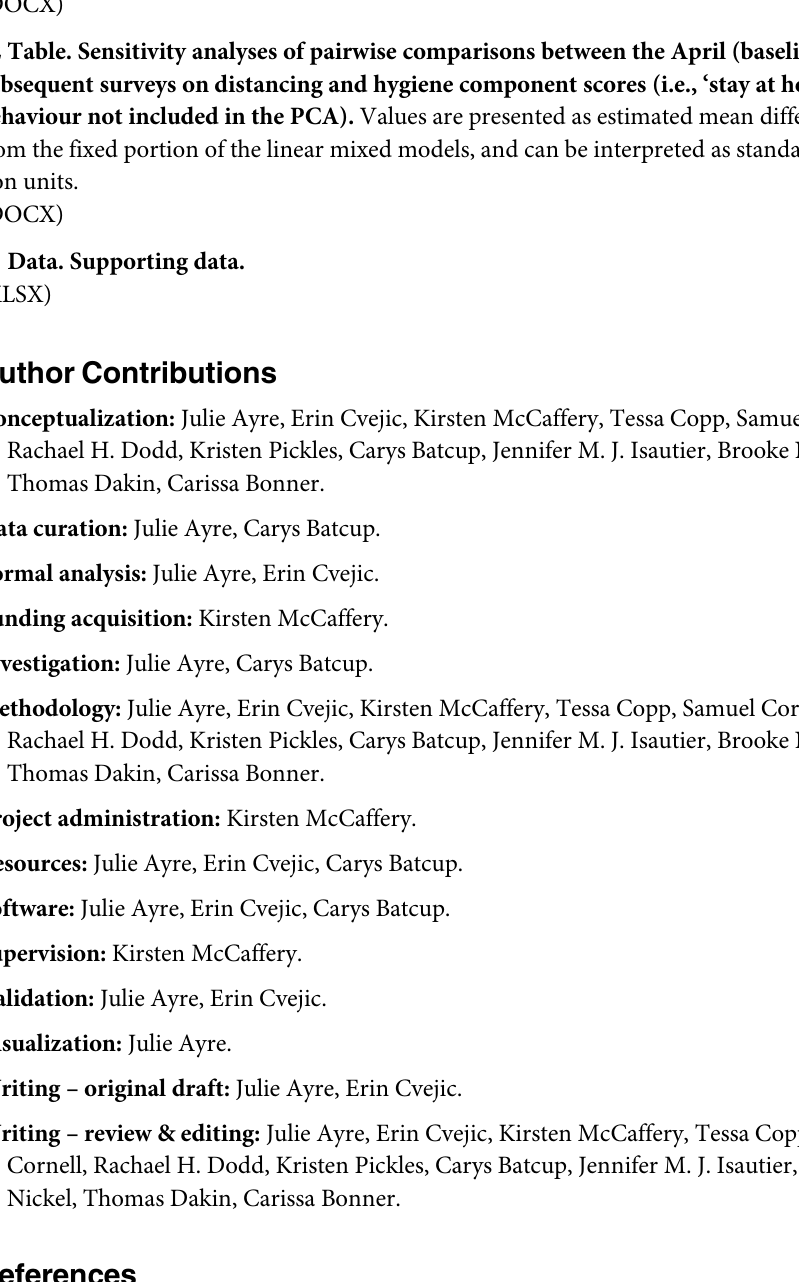
S1 Table. Descriptive characteristics of analysis sample (N = 1843) and full sample invited for follow-up (N = 3216) at baseline (April). S2 Table. Sensitivity analyses of pairwise comparisons between the April (baseline) and subsequent surveys on distancing and hygiene component scores (i.e., ‘stay at home’ behaviour not included in the PCA). Values are presented as estimated mean differences from the fixed portion of the linear mixed models, and can be interpreted as standard devia- tion